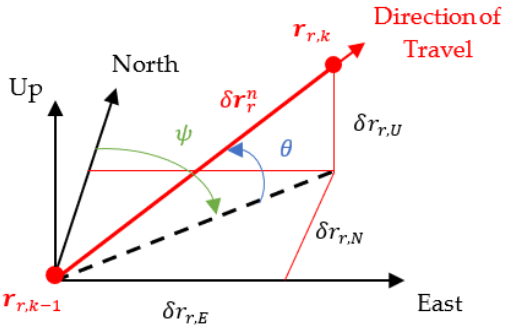
Figure 3. Illustration of the heading and pitch angle computation using the delta position vector of the receiver expressed in the navigation frame ( n -frame).